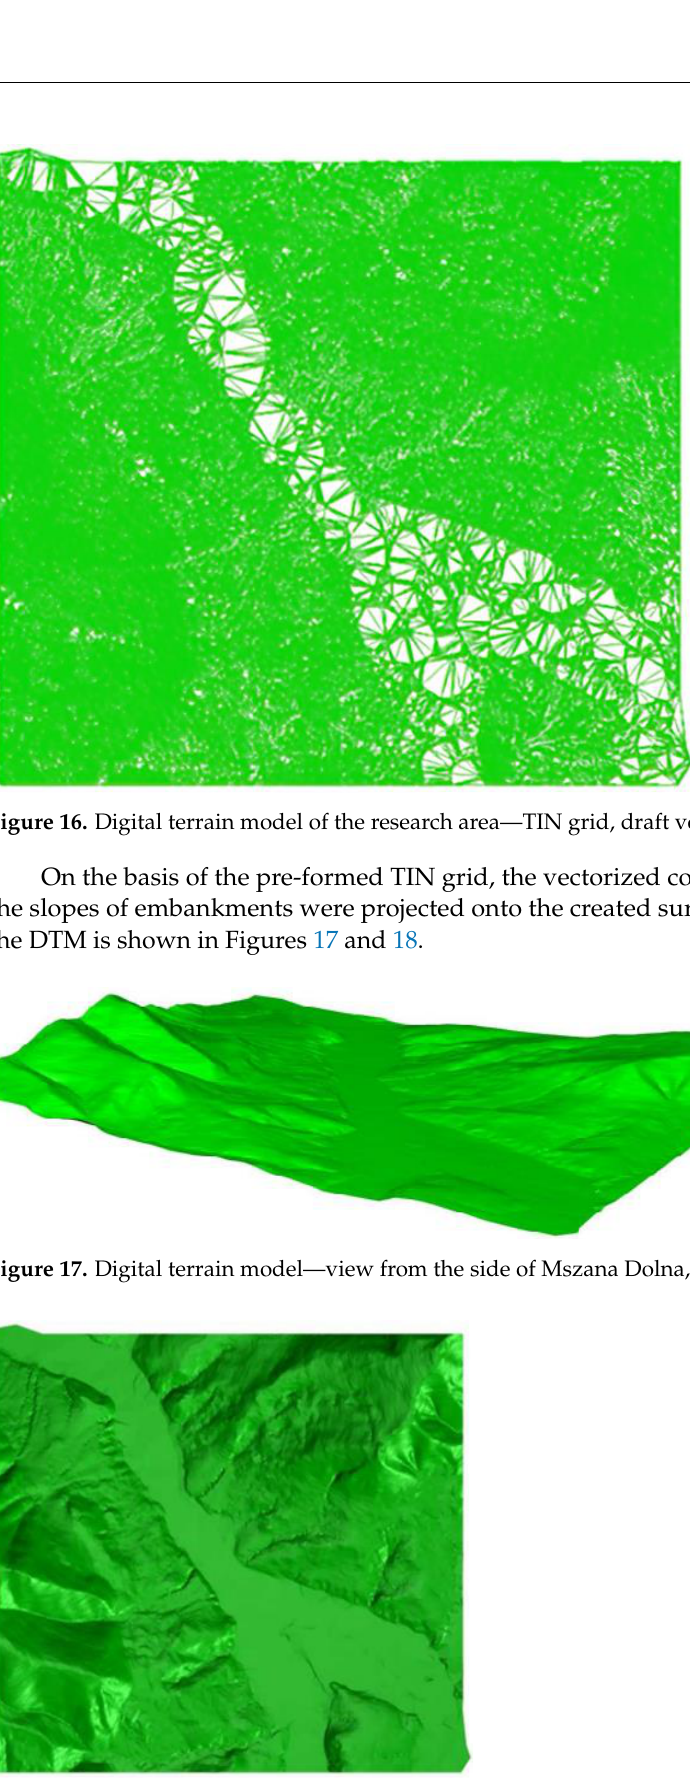
19 of 29 Figure 15. Digital terrain surface model — Kasinka Mala. A digital terrain surface model was used as a basis for carrying out additional re-